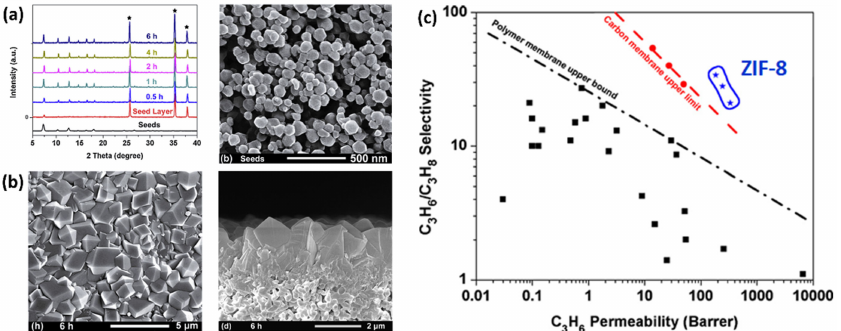
Figure 5. ( a ) XRD patterns of ZIF-8 seeds, seeded support and membranes grown at different conditions ( Left ), and SEM image of seeds ( Right ). ( b ) Top-view and cross-section SEM images of ZIF-8 membrane. ( c ) Propylene/propane separation performances in terms of selectivity and propylene permeability for polymer, carbon molecular sieve, and ZIF-8 membranes